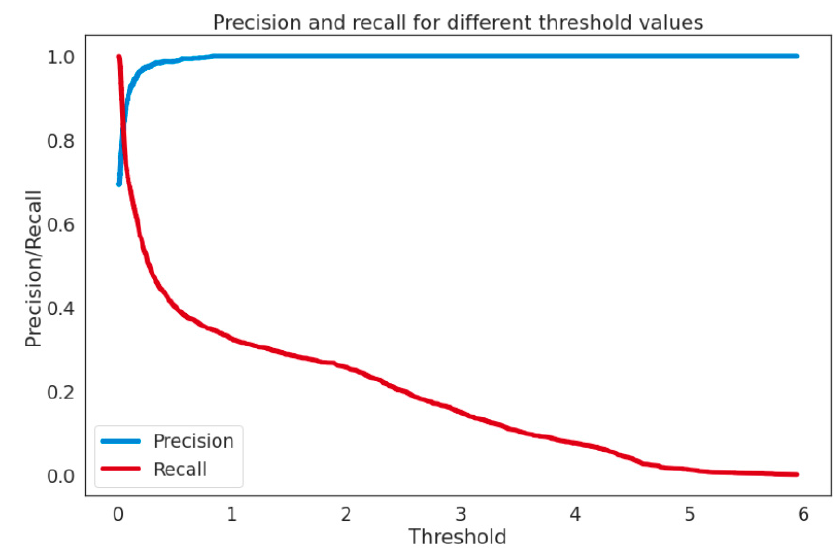
Figure 7. Precision and recall trend of Statlog (Landsat Satellite) dataset.